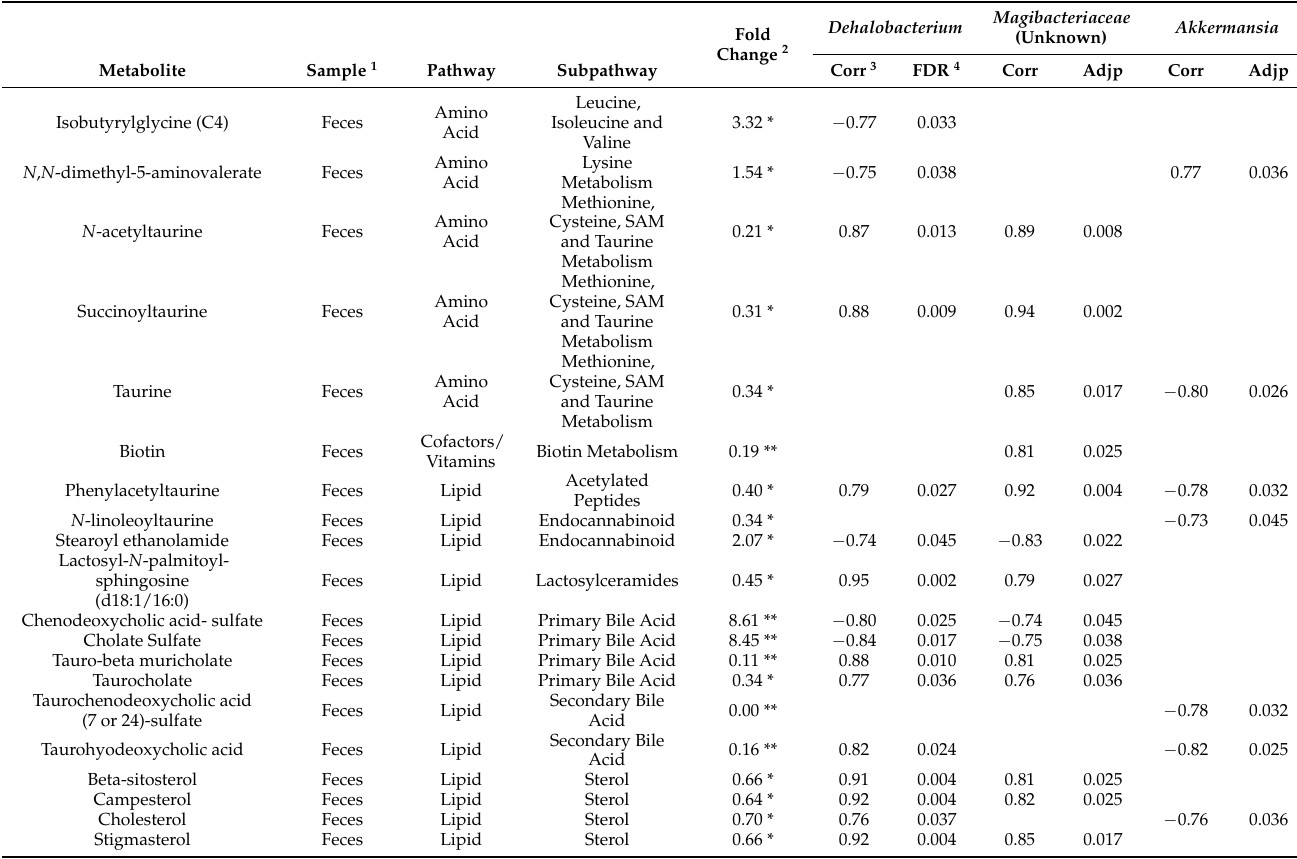
Table 3. Correlation analysis between fructose-responsive fecal metabolites and fecal microbiota in B6 mice.